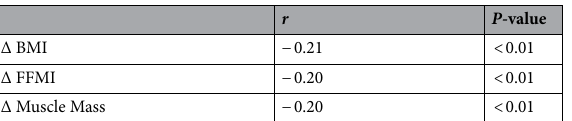
Table 3. Correlation between annual ΔLAA% and nutritional status change. BMI body mass index, FFMI fat- free mass index, LAA% the ratio of low attenuation area to total lung